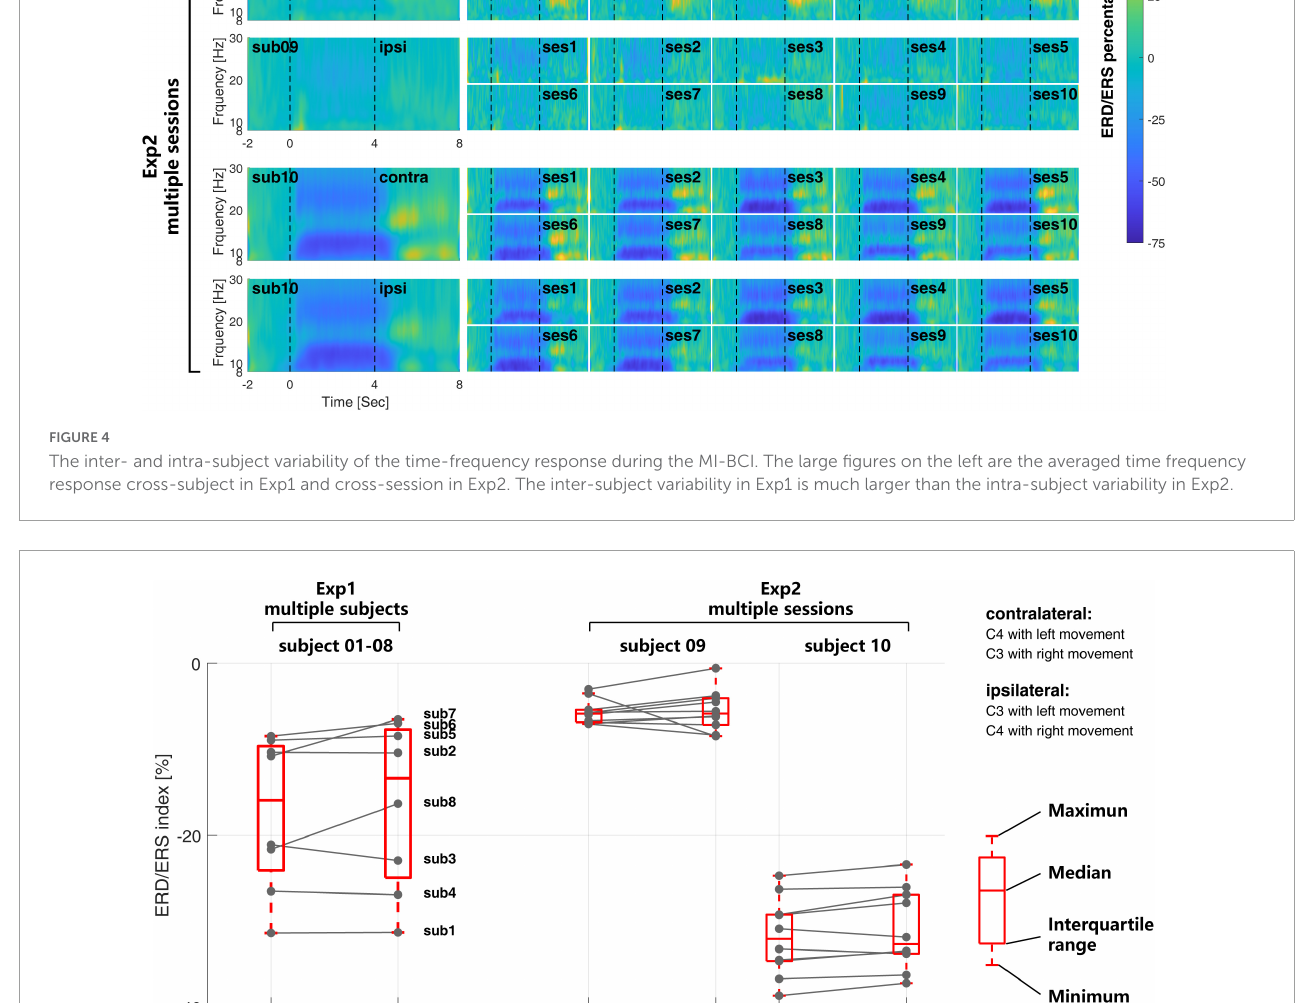
Frontiers in Neuroscience